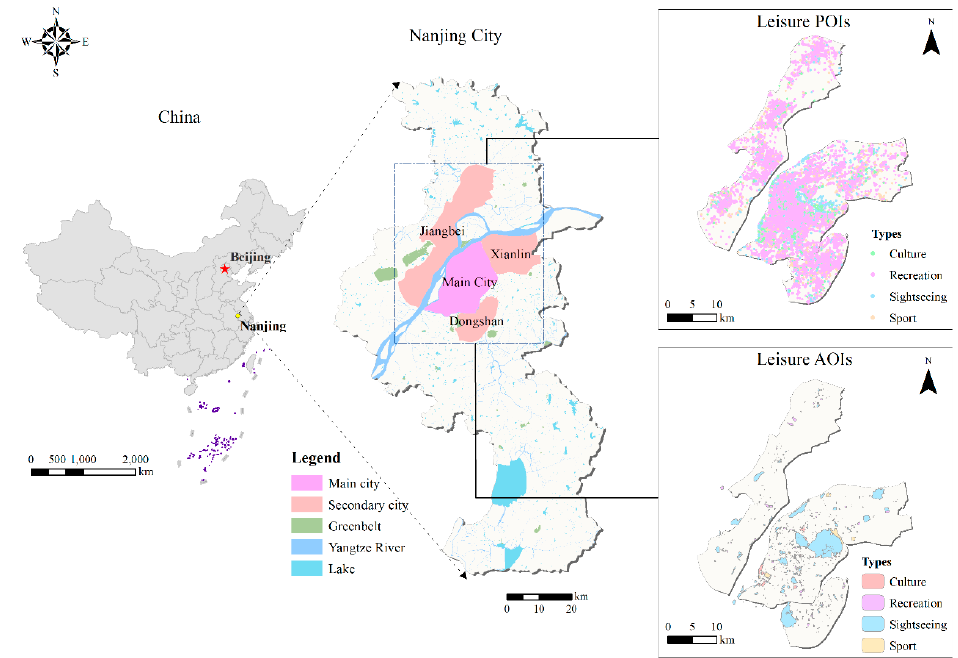
Figure 1. Study area and the distribution of leisure-related POIs and AOIs.